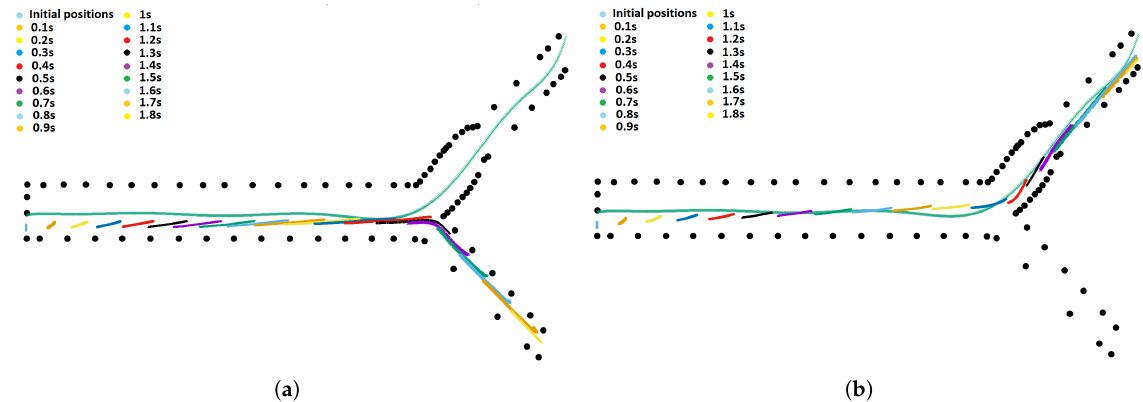
Figure 6. Projection of the positions of particles under different time steps of the navigation process for particles with diameter of ( a ) 200 nm and ( b ) 500 nm. Desired trajectory (cyan line) and walls (black dots).